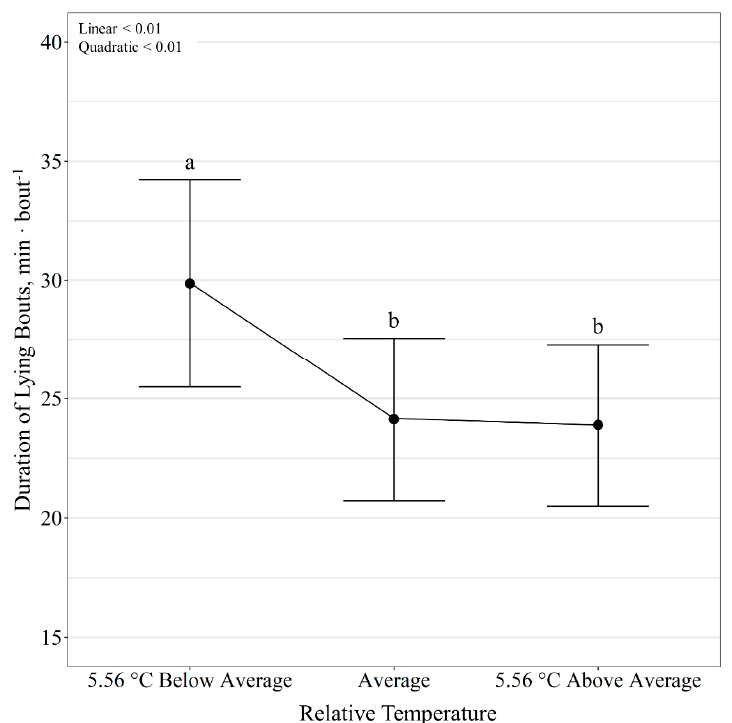
Figure 7. Influence of relative temperature change on lying time ( p < 0.01; expressed as min bout − 1 ) by beef steers consuming either barley or corn-based feedlot diets at the Northern Agricultural Research Center, Havre, MT, USA. Data points without a common letter differ ( p < 0.05).